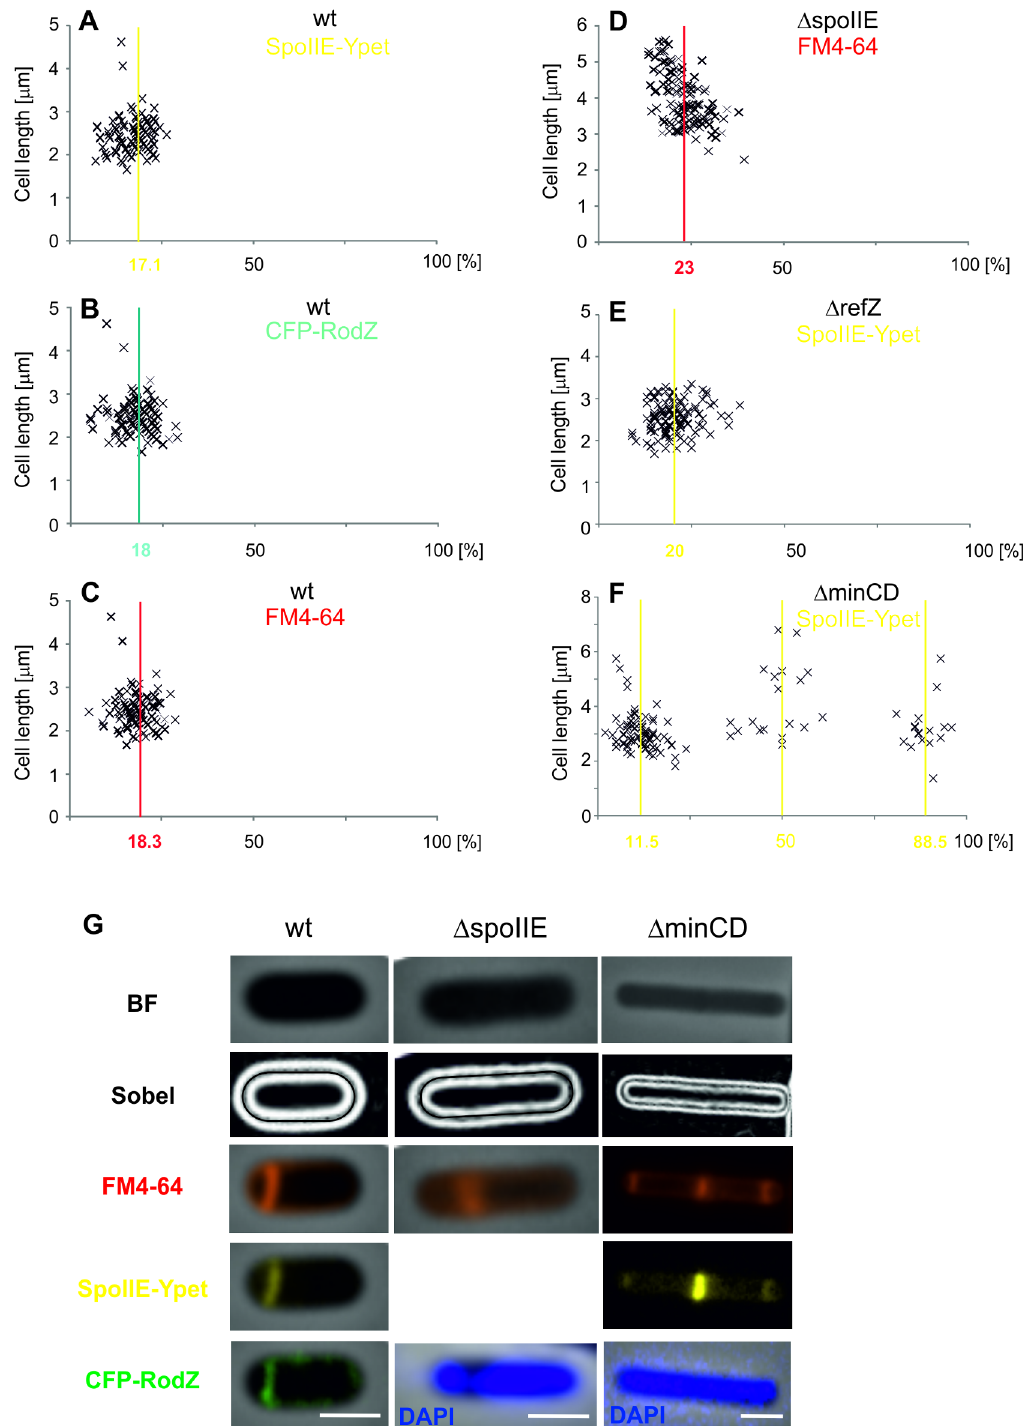
Fig 1. The sporulation septum position in wild type, Δ SpoIIE, Δ RefZ and Δ MinCDstrains. The average position of the sporulation septum is measured from the nearest cell pole, and expressed as a percentage of the total cell length (x-axis). Y-axis represents the cell length in μm. (A) The sporulation septum position in IB1538 based on the SpoIIE-Ypet signal. (B) The sporulation septum position in IB1538 based on the CFP-RodZ signal. (C) The sporulation septum position in IB1538 based on the FM4-64 membrane dye signal. (D) The sporulation septum position in the PY180 ( Δ spoIIE )strain based on the FM4-64 membrane dye signal. (E) The sporulation septum position in IB1723 ( Δ refZ ) based on the SpoIIE-Ypet signal. (F)